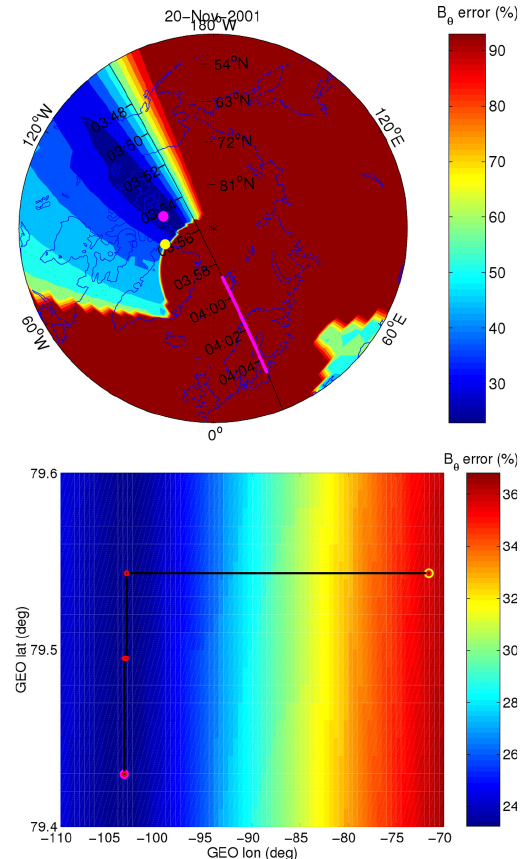
Fig. 8. Top: a typical example of the 1-D:ness optimization. The black line with the time stamps shows the track of the CHAMP satellite. The 1-D optimized part (overflight) is highlighted in ma- genta. The color coding displays the B θ 0 error for the overflight, as a function of the 1-D SECS pole location. The yellow dot shows the starting point for the optimization at the geomagnetic pole and the magenta dot the resulting 1-D SECS pole at 79 ◦ latitude and − 103 ◦ longitude with B θ 0 error 23%. Bottom: a zoom in of the top panel showing also the steps taken during the optimization as red dots connected by black lines. Reproduced from Fig. 6 of Juusola et al.